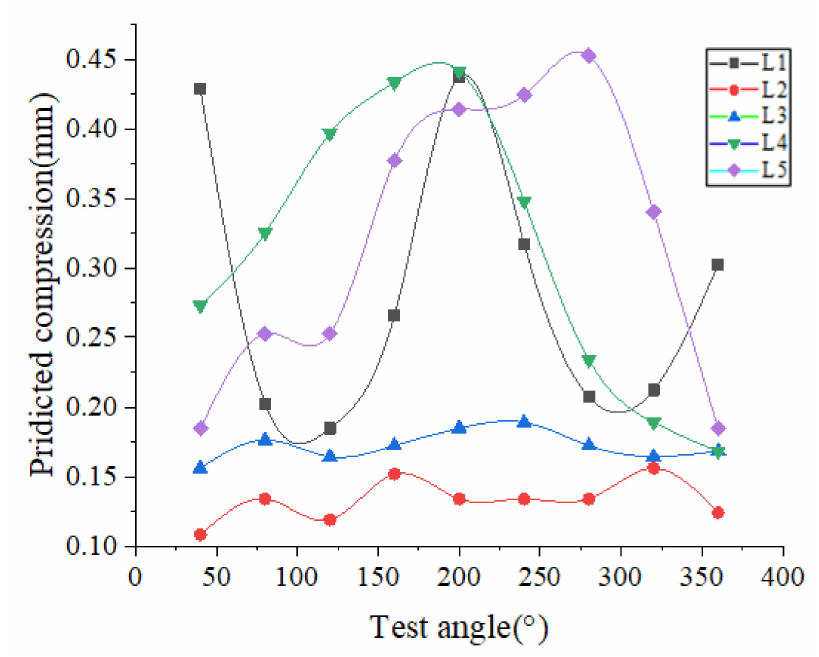
Figure 10. Predicted compression under synergy